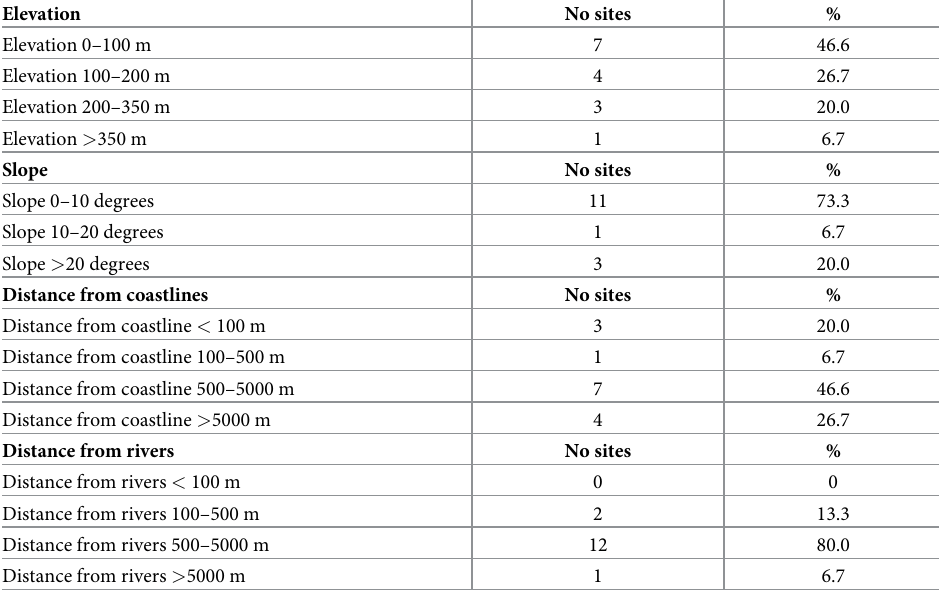
Table 2. Analysis outcomes of the main topographic patterns of Terminal Pleistocene and legacy Palaeolithic sur- face lithic assemblages from Cyprus.